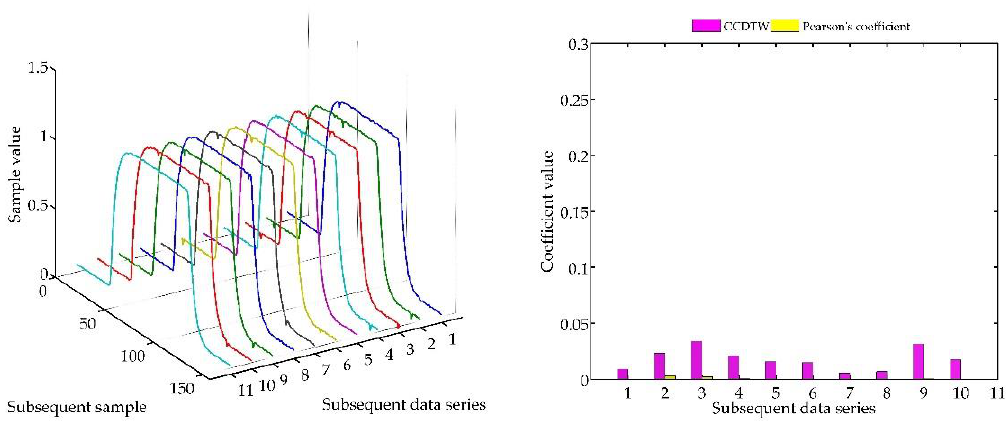
Figure 26. Data comparison results achieved in the measurement experiment for r ampl = 2.